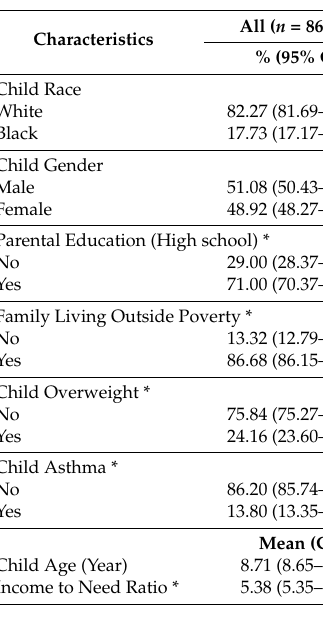
Table 1. Descriptive statistics in the pooled sample and by